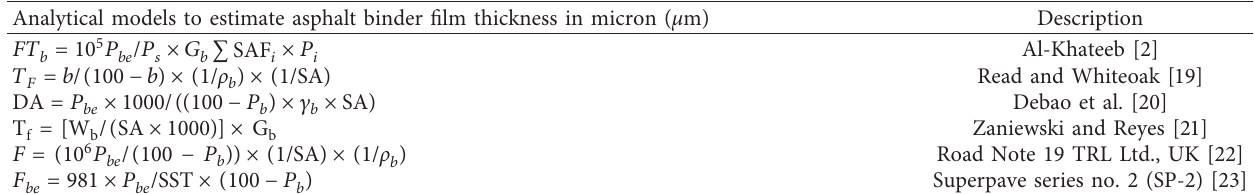
Table 3: Analytical models to estimate asphalt binder film thickness in